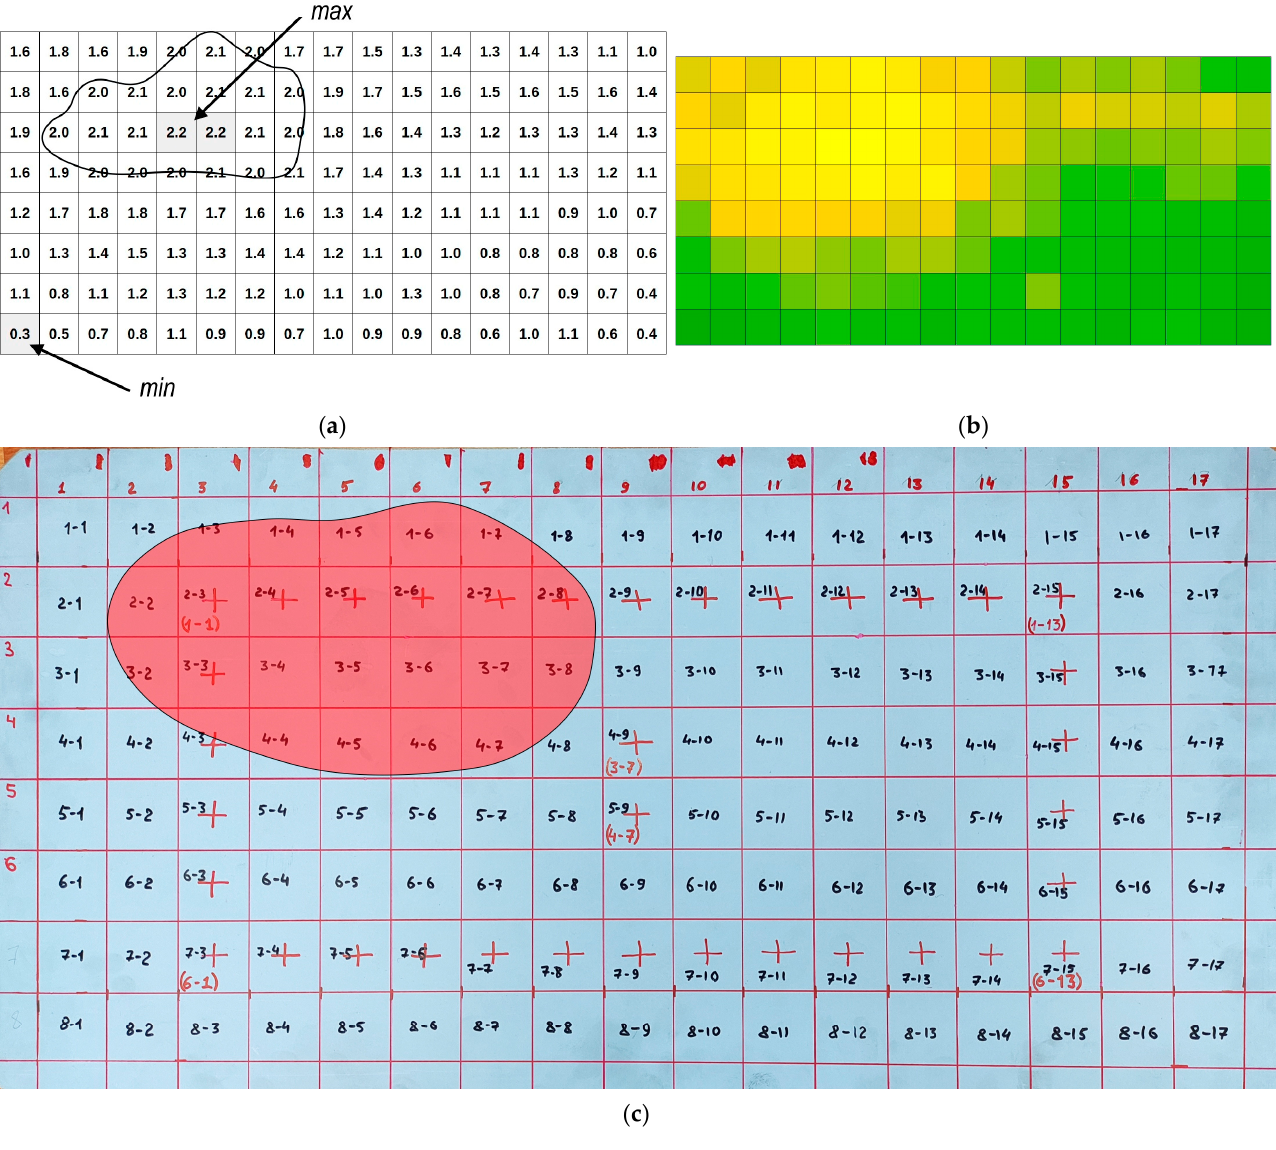
Figure 6. Image options for the detected defect: ( a ) numerical display of the measured values of the loss (dB) at the control points; ( b ) digital image obtained by color processing of the measurement results; ( c ) defect zone on a real structure.